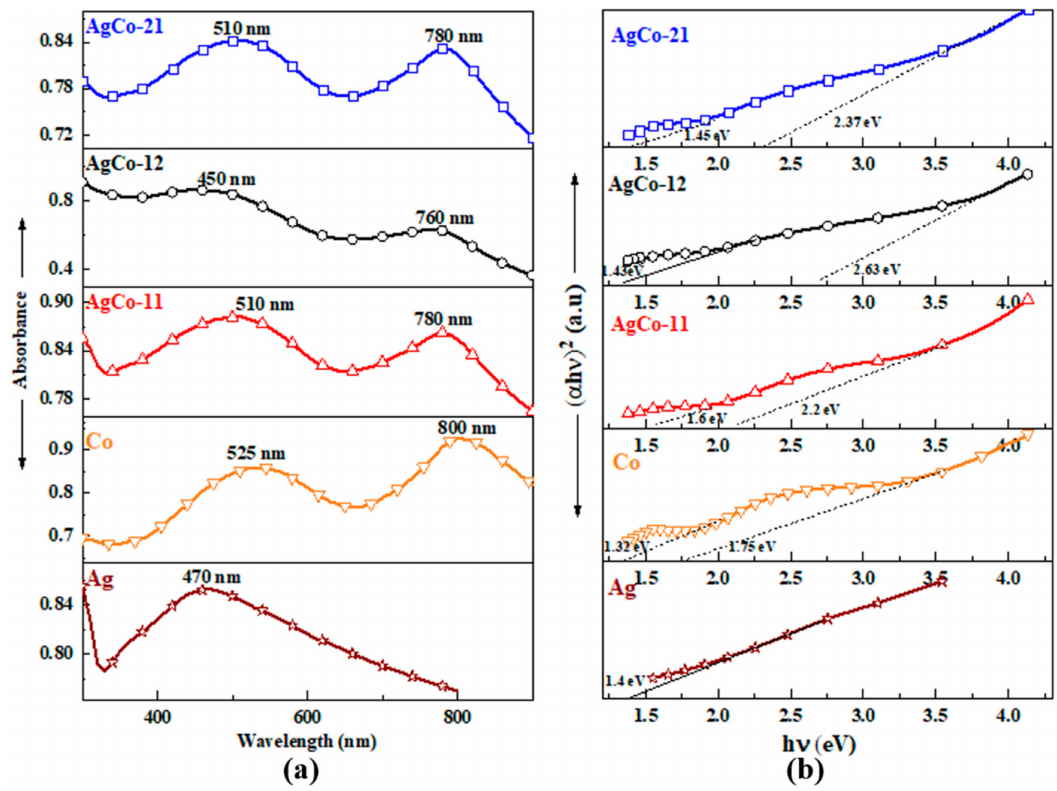
Figure 3. ( a ) UV-Vis absorption spectra of monometals Ag and Co, and alloyed Ag-Co compounds in aqueous solution; and ( b ) their corresponding Tauc